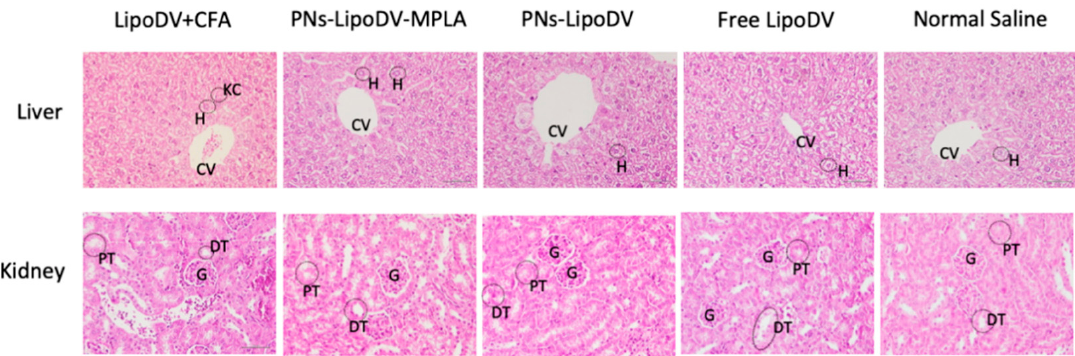
Figure 7. Histologic section of liver and kidney tissues of the immunized mice. Sections were stained with H&E and examined at 40× magnification. CV = central vein, KC = Kupffer cell, G = glomerulus, H = hepatocyte, PT = proximal convoluted tubules, DT = distal convoluted tubules.